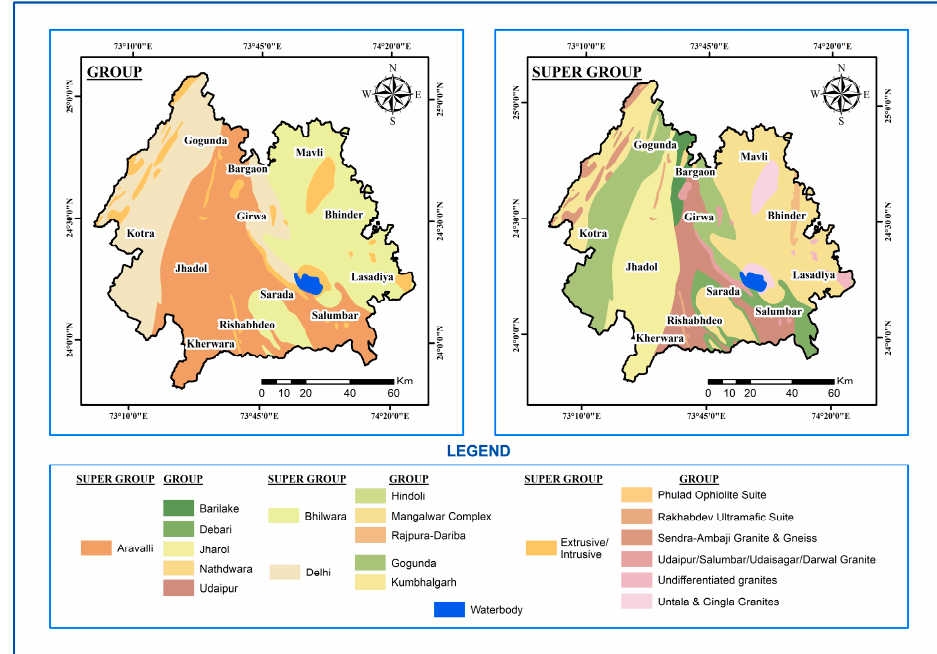
Figure 6. The distribution of aquifer in different groups in the Udaipur district.